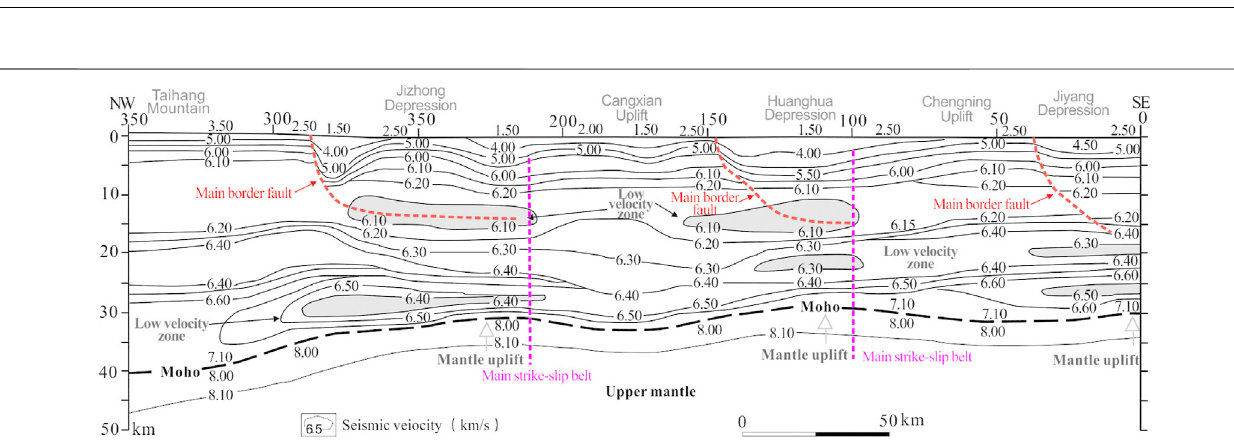
Frontiers in Earth Science |